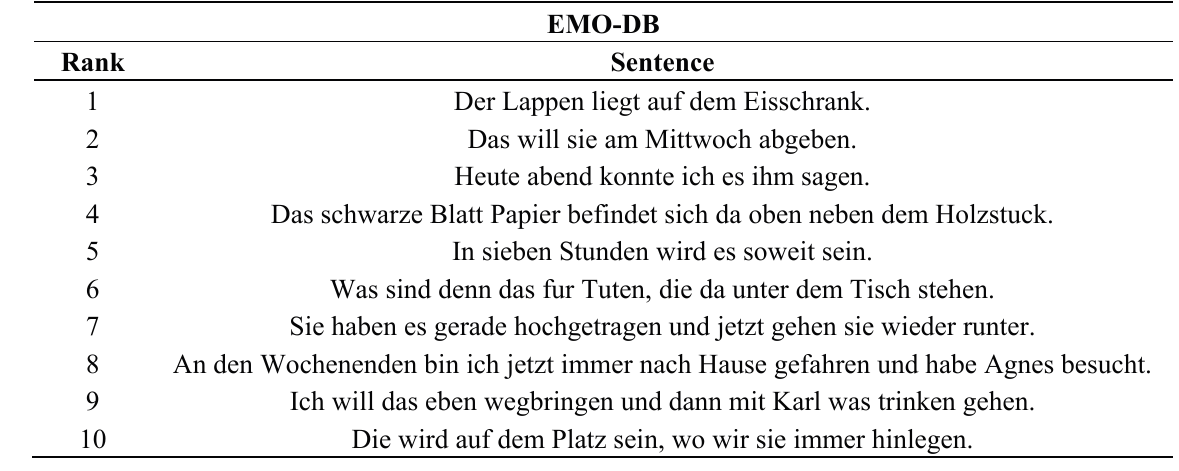
Table 1. The emotional sentences for EMO-DB.